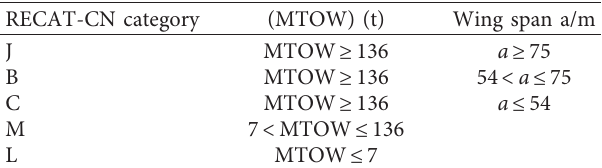
Figure 4: UHC reference emission index. E curve with λ , red dot as measurement value, black box as the estimated value. 1 ,r Table 5: RECAT-CN classification standard.